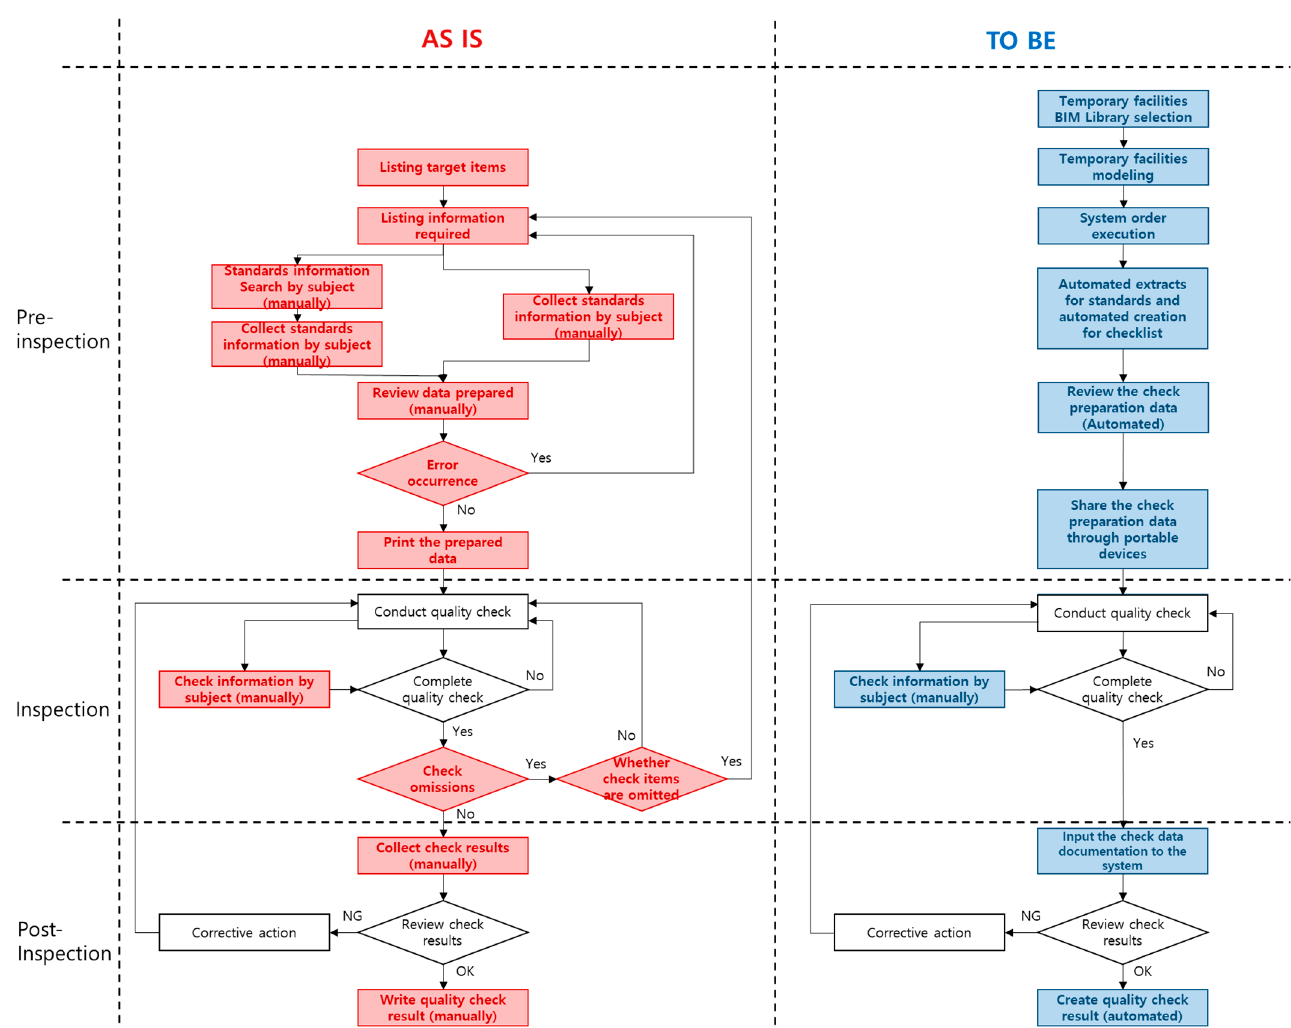
Figure 2. Comparison of TCW quality inspection unit works (AS-IS vs. TO-BE).